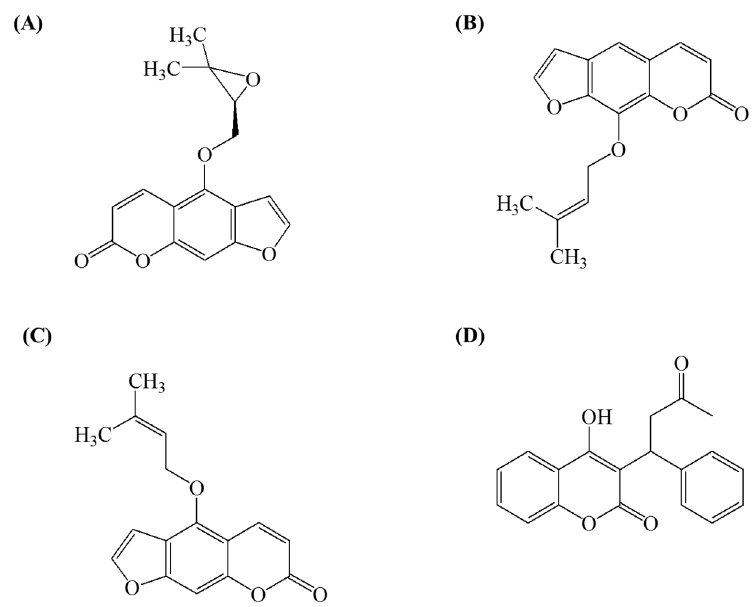
Figure 5. Chemical structures of oxypeucedanin ( A ); imperatorin ( B ); isoimperatorin ( C ); and warfarin (internal standard, D ).